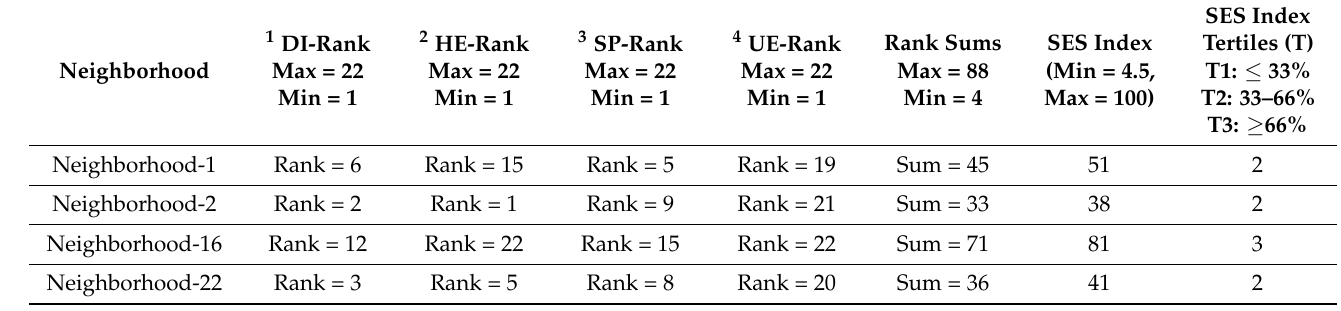
Table 1. Description of the process of indexing the socioeconomic status of the 22 neighborhoods in the city of Västerås. Note that not all 22 neighborhoods are shown, but rather an